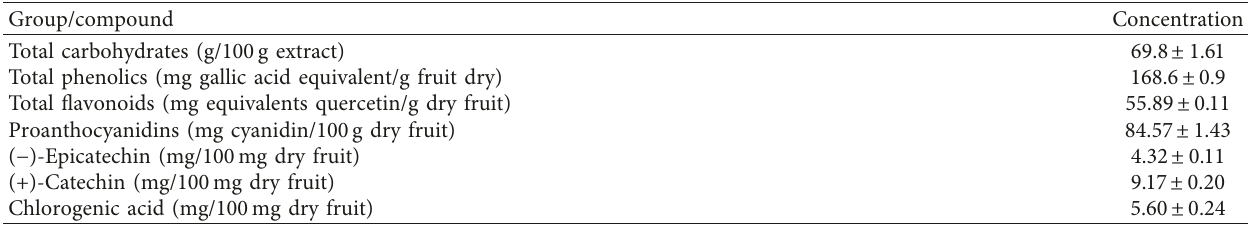
Table 1: Phytochemical characterization and content of free polyphenolic compounds in Crataegus pubescens fruits.